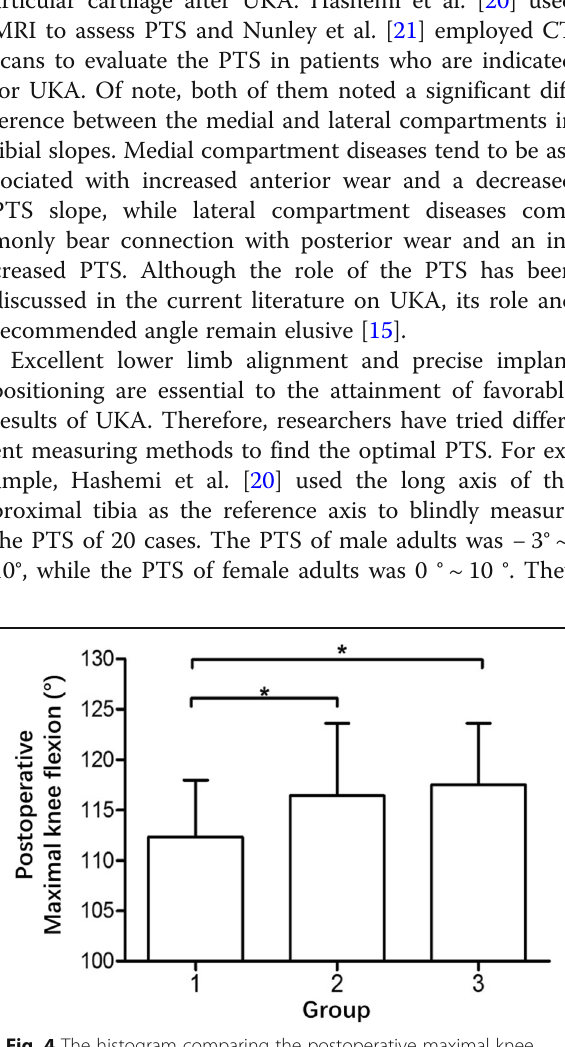
Fig. 4 The histogram comparing the postoperative maximal knee flexion between the three groups with different ranges of PTS. * p <